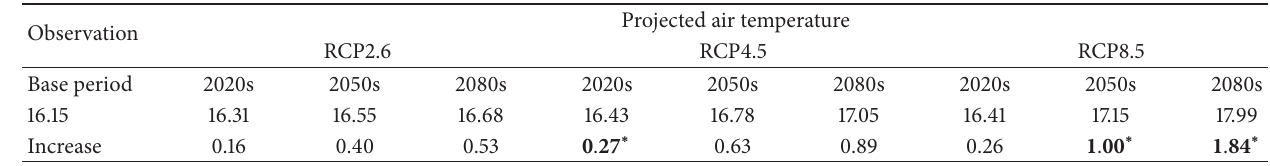
Table 1: Areal average of future daily temperature ( ∘ C) compared with the base period. Projected air temperature Observation RCP2.6 RCP4.5 RCP8.5 Base period Increase 0.16